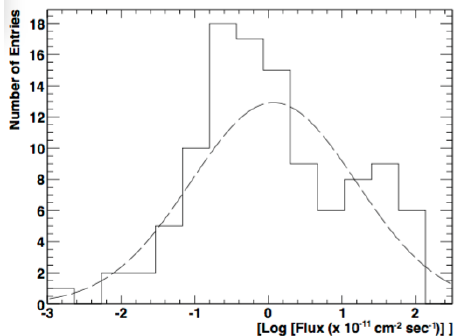
Figure 5. Distributions of VHE fluxes ( ≥ 2 TeV) for the flare of Mkn 501 during 19–24 June 2014 based on a four-minute time binning. Furthermore, in this case, a log-normal distribution (dashed curve) is preferred over a Gaussian. The difference is not as significant, though (see also [42]), and one could also speculate whether the sum of two Gaussians might provide a better characterization of the log(flux)-distribution. From